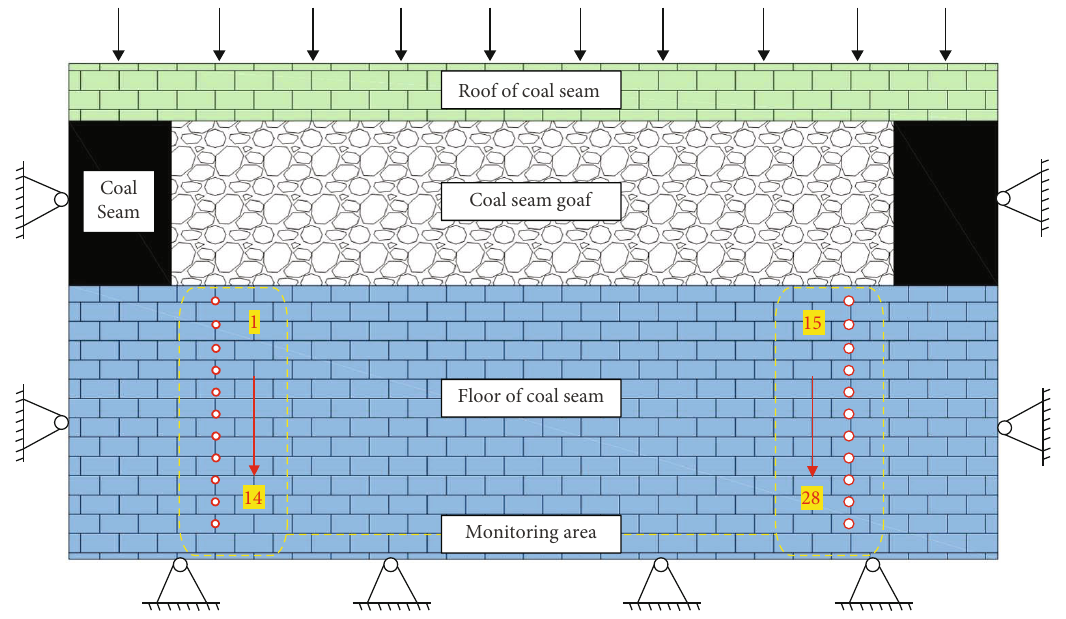
Figure 6: Shear stress and shear strain monitoring